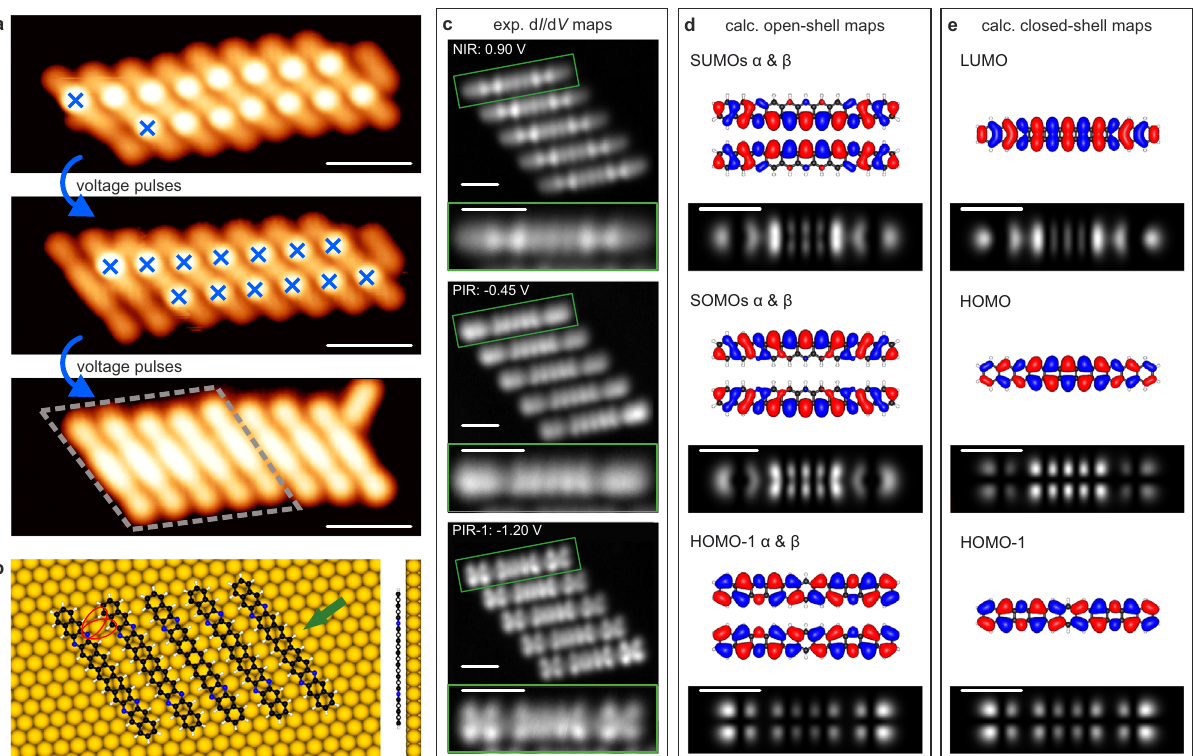
Fig. 4 On-surface synthesis of tetraazaundecacene 3 via STM tip-induced cleavage of the ethano protecting groups of 5 and electronic characterization. a Successive STM topography images illustrating the cleavage process. Top image shows a cluster of 5 (leftmost molecule has already one bridge cleaved) with blue crosses indicating the locations where the voltage pulse is applied. Middle image shows the intermediate state after two voltage pulses, and bottom image shows the fi nal result after applying a voltage pulse to all the molecules of the cluster. Scale bars: 5 nm. b DFT-calculated equilibrium geometry of a cluster of fi ve molecules of 3 . Red ovals indicate hydrogen bonds. The side view is shown for a single molecule in the direction indicated by the green arrow. c Experimental constant-height d I /d V maps of the frontier states for a cluster of fi ve tetraazaundecacene molecules. PIR − 1, PIR, and NIR stand for the second positive, the positive, and the negative ion resonances, respectively. Each map includes a zoom-in of a single molecule indicated by the green rectangle. Scale bars: 1 nm. d , e DFT-calculated molecular orbitals ( α , β denote the two spin channels) and LDOS mappings at height 5 Å for the broken-symmetry open-shell singlet and the closed-shell state, respectively. Scale bars: 1